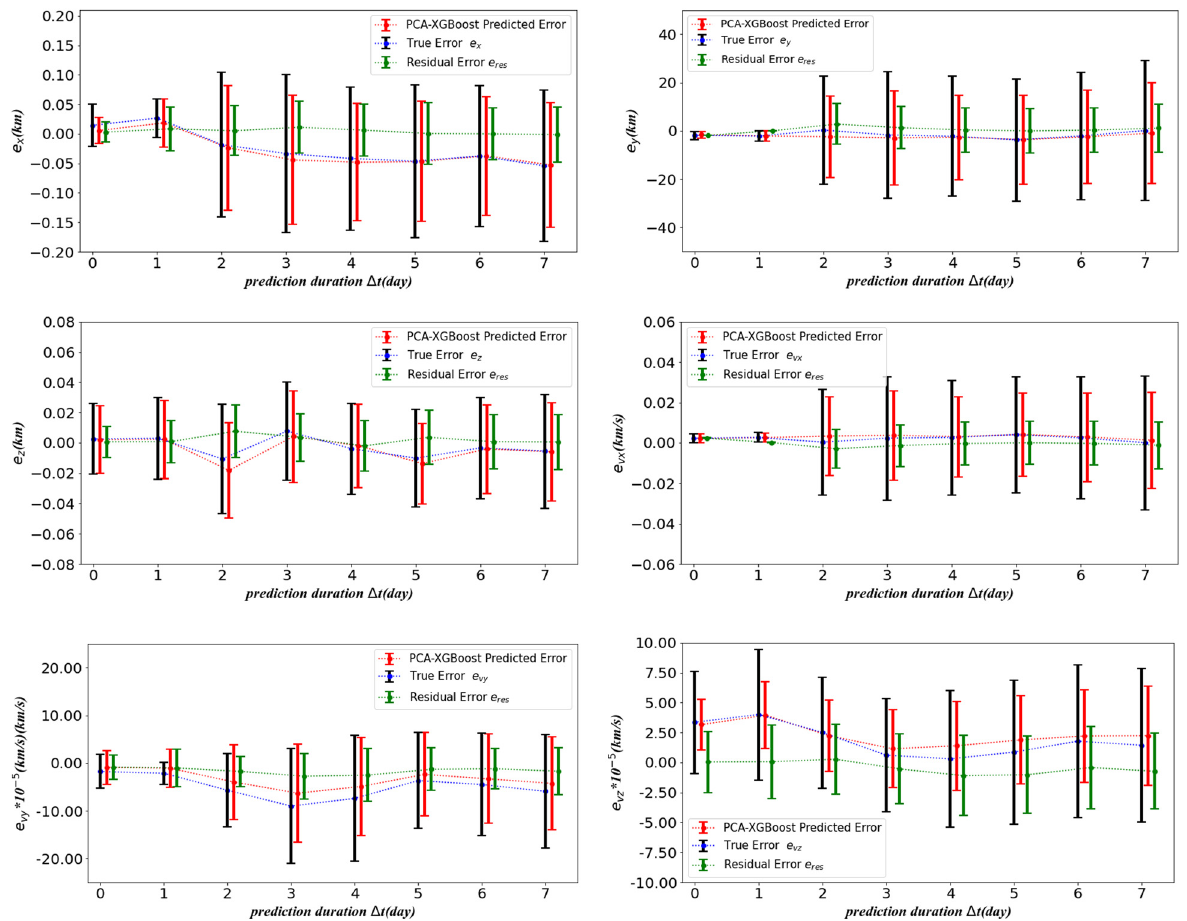
Figure 6: Performance of PCA – XGBoost model on testing dataset. ( a ) = P 29.86% , ( b ) = P 14.95% , ( c ) = P 46.41% , ( d ) = P 10.32% , ( e ) = P 36.38% , and ( f ) = P 51.46%